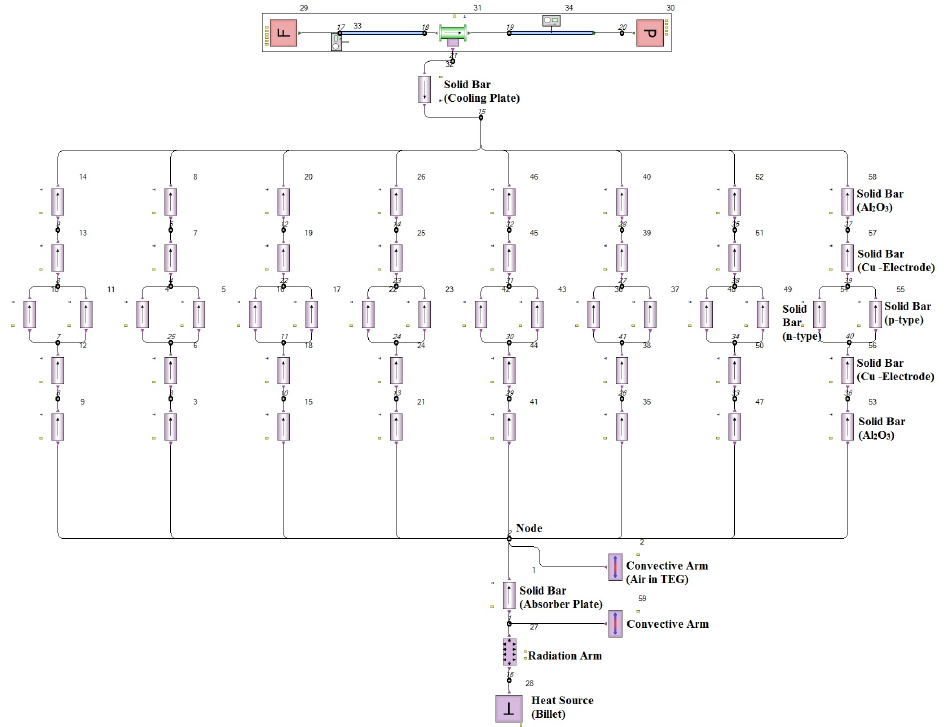
Figure 5. One dimensional heat transfer network used in FloMASTER TM for the analysis.